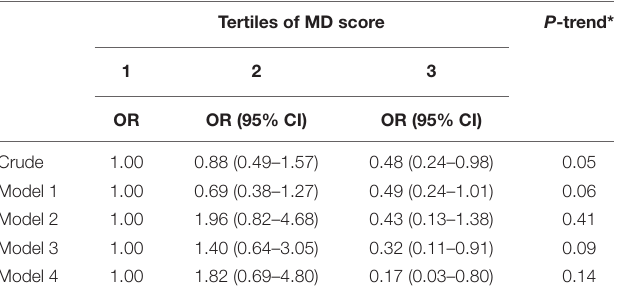
TABLE 3 | Odds ratios (ORs) and 95% CIs of gastric cancer according to tertiles of the Mediterranean dietary score. Tertiles of MD score P